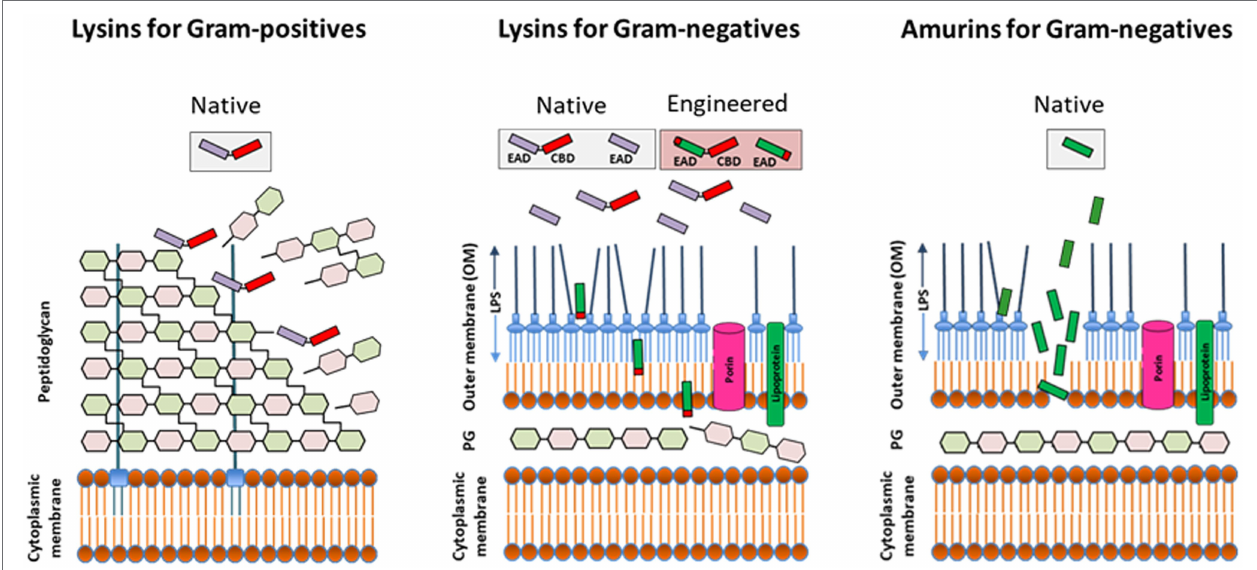
FIGURE 2 | Direct lytic activity of purified (recombinant) lysins and synthesized amurin peptides applied exogenously to susceptible pathogens. The lysin class of Direct lytic agents (DLAs) consist of cell wall hydrolases targeting the surface exposed peptidoglycan of Gram-positives and the internal peptidoglycan layer of Gram-negatives. While native (unmodified) lysins are effective against Gram-positives, they require engineering to displace or disrupt the outer membrane (OM) and facilitate access to subjacent peptidoglycan in Gram-negatives. The amurin peptide class of DLAs has a non-murolytic MOA based on disruption of the OM. EAD, enzymatically active domain; CBD, cell wall-binding domain; PG, peptidoglycan; and LPS,